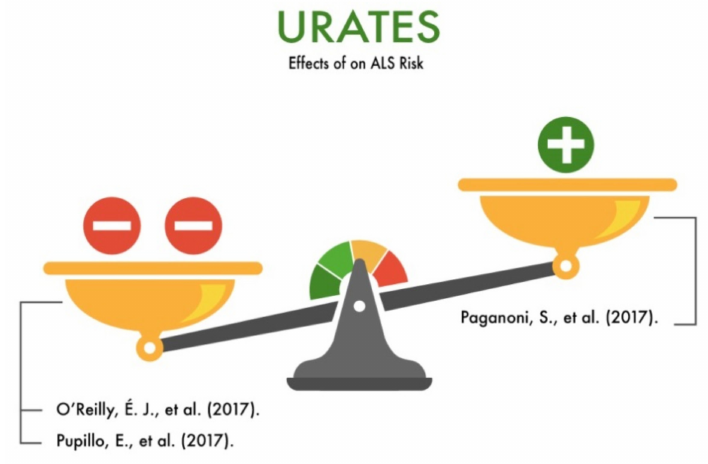
Figure 13. The effect of urates and purines on the risk of developing amyotrophic lateral sclerosis